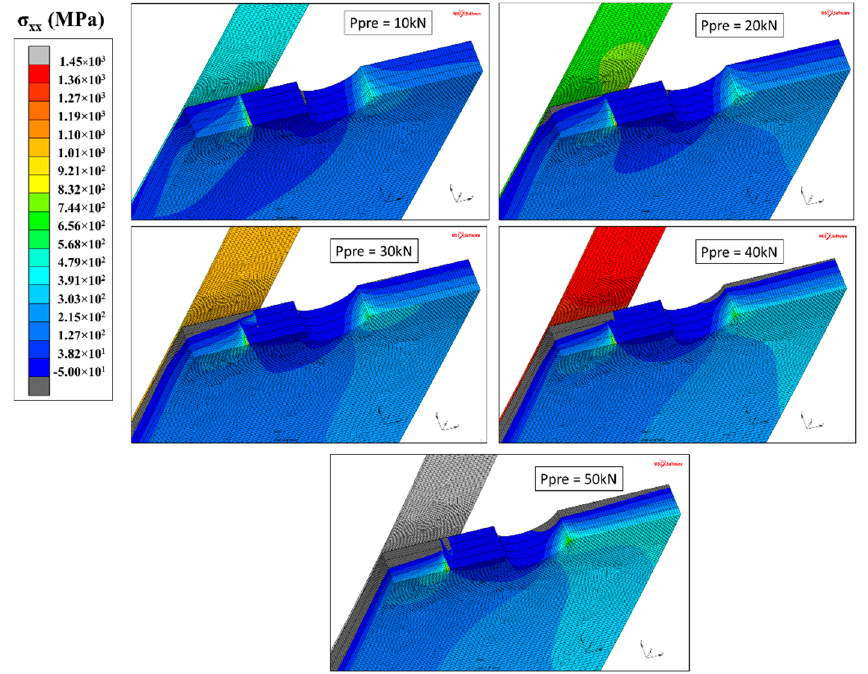
Figure 15. Compressive stress state in the steel plate according to the pre-stressing force in the CFRP laminate.